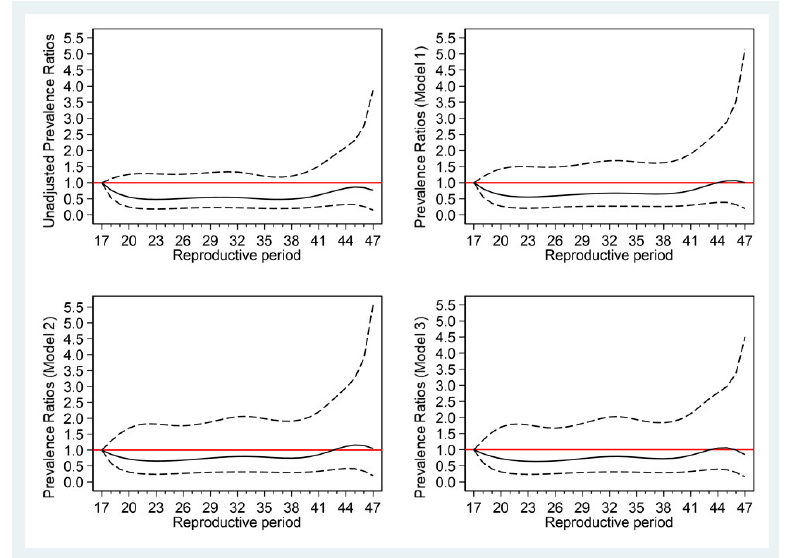
Figure 2. Prevalence ratios (solid line) and 95% confidence intervals (dashed lines) of the reproductive period for type 2 diabetes mellitus (T2DM) (reference: 17 years). Model 1: age; Model 2: age, BMI, parental history of T2DM, age at menarche, pregnancies, marital status; Model 3: age, BMI, parental history of T2DM, age at menarche, pregnancies, marital status, education, smoking, alcohol, exercise, hypertension, hyperlipidemia.